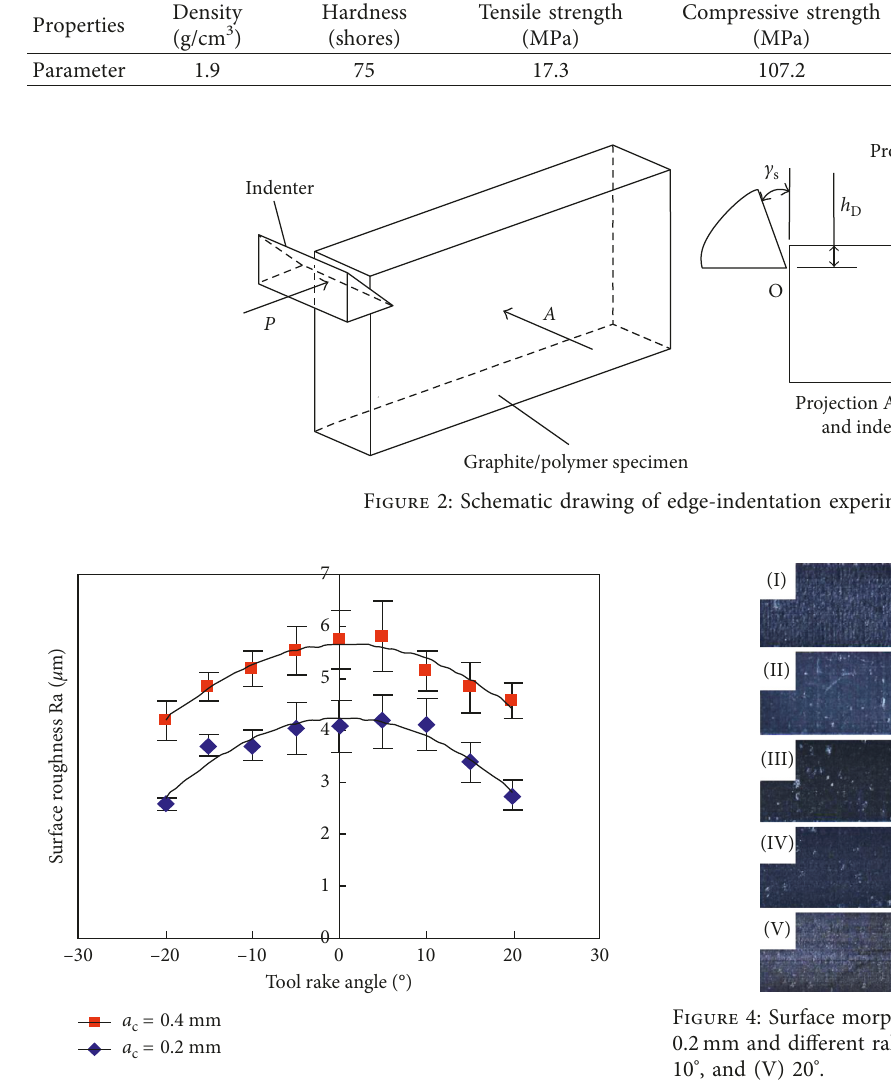
Figure 3: Machined surface roughness of graphite/polymer composites at different rake angles.